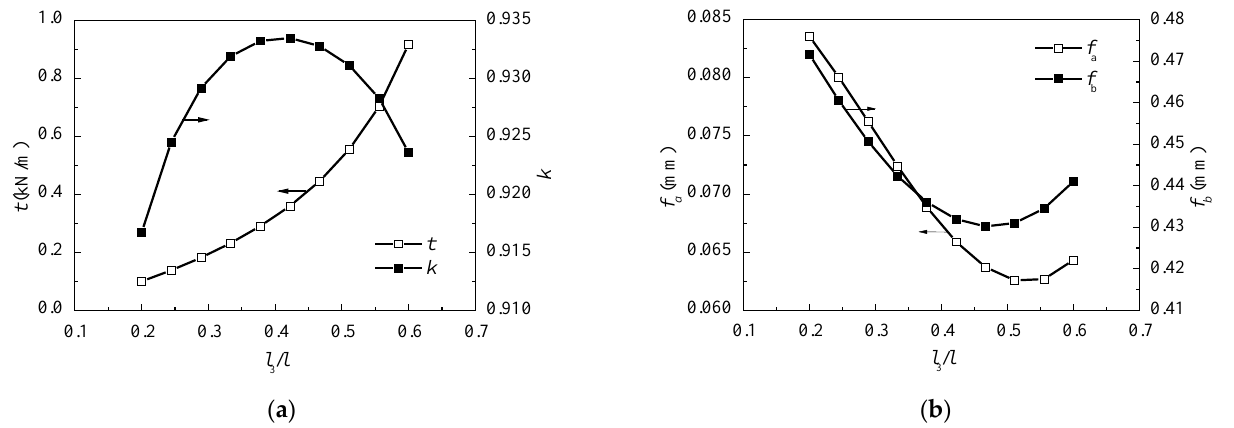
l l k and t , ; and ( b ) the relationships between 3